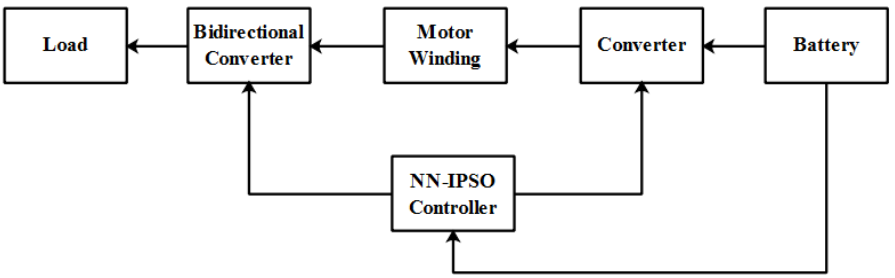
Figure 2. General block diagram of the battery-based converter.